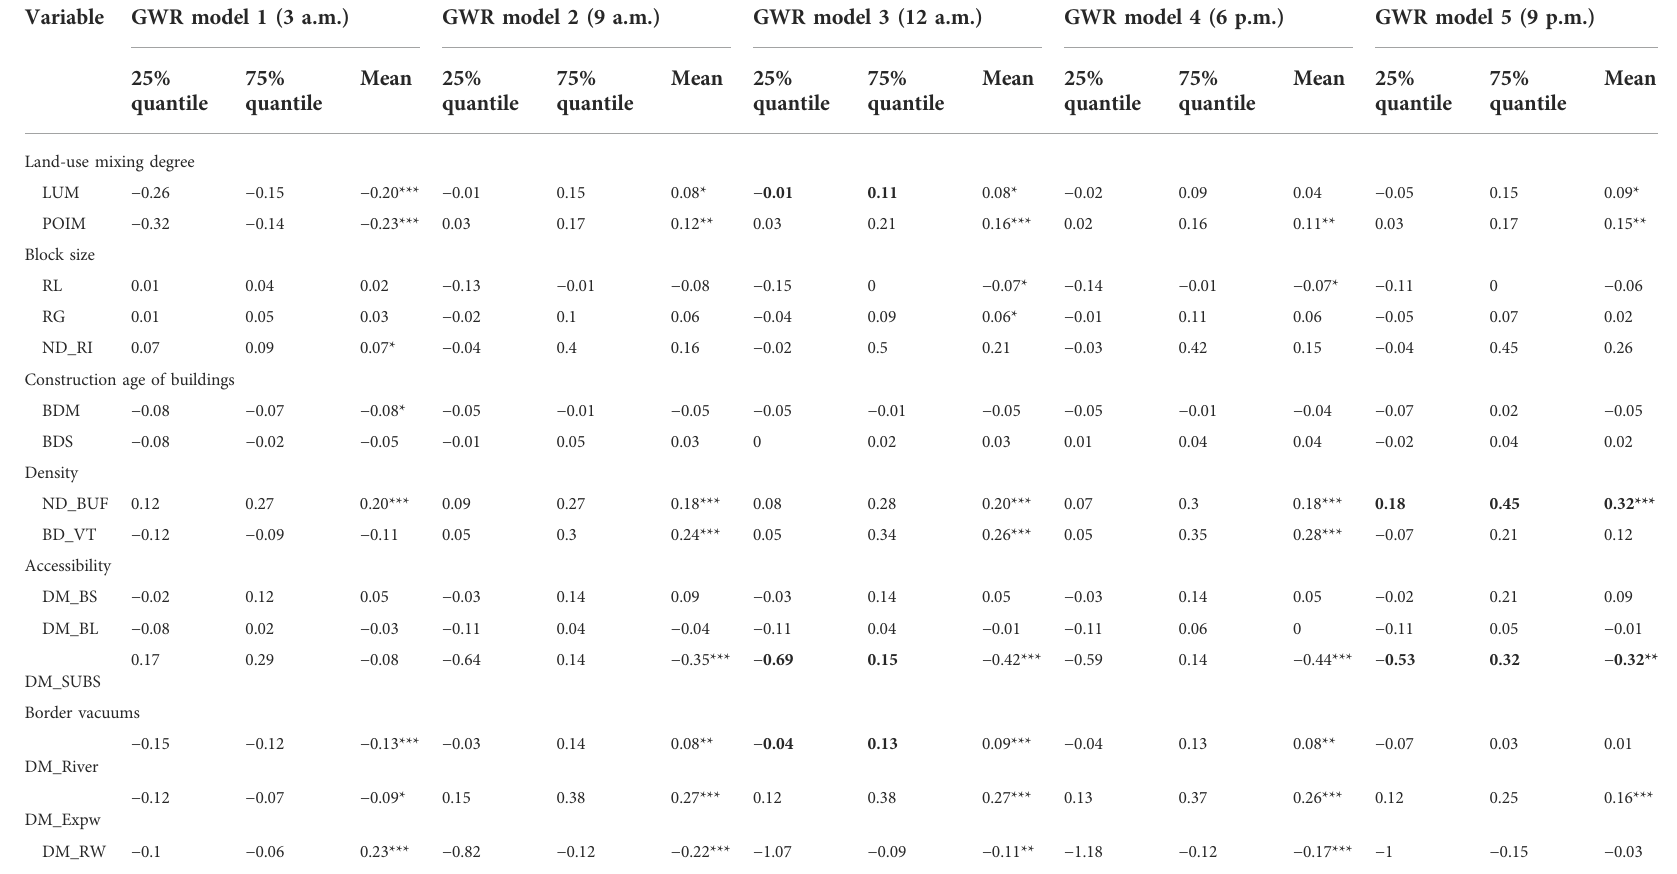
TABLE 4 Coef fi cients of GWR model